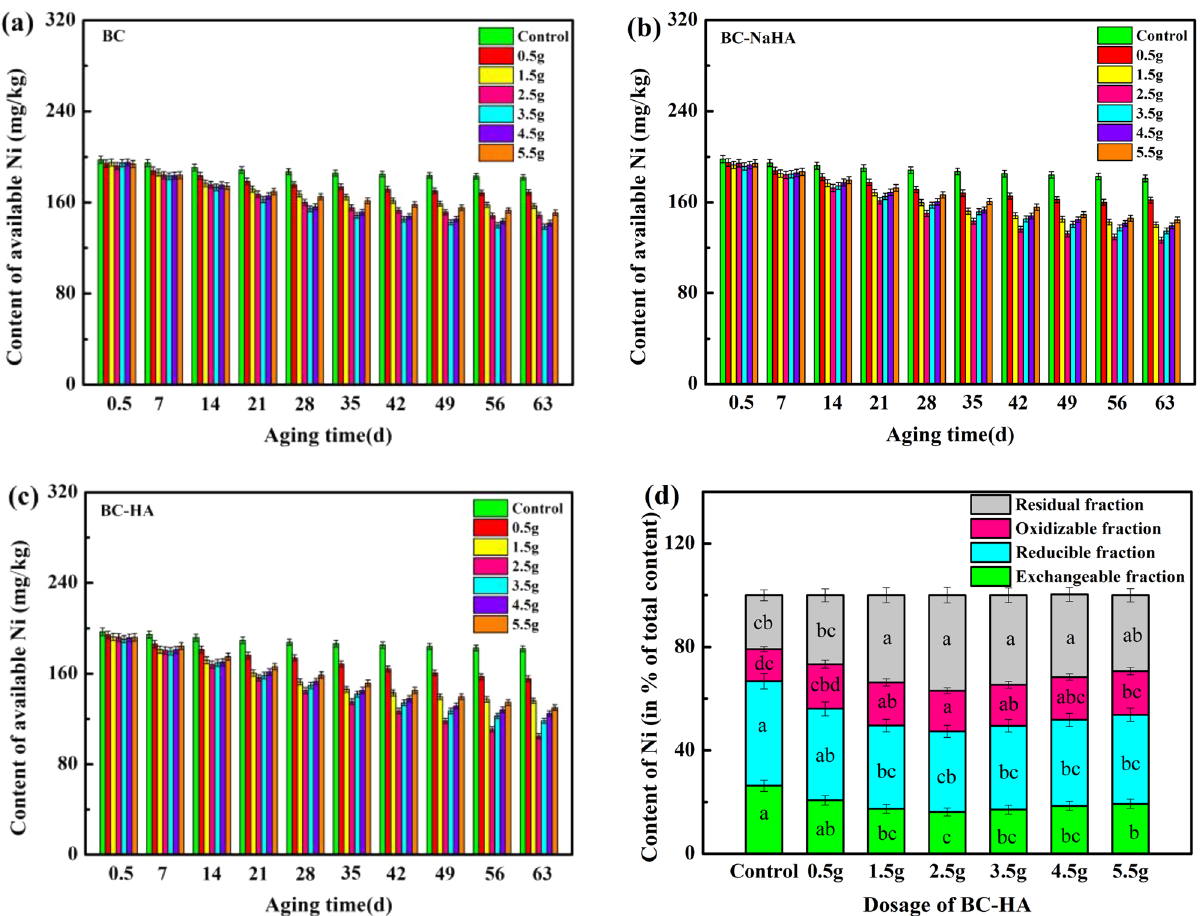
Figure 1. The effect of ( a ) BC, ( b ) BC-NaHA, ( c ) BC-HA with different addition amounts with aging time on the available nickel in the soil; ( d ) The effect of the addition of BC-HA on the four chemical components of nickel in the